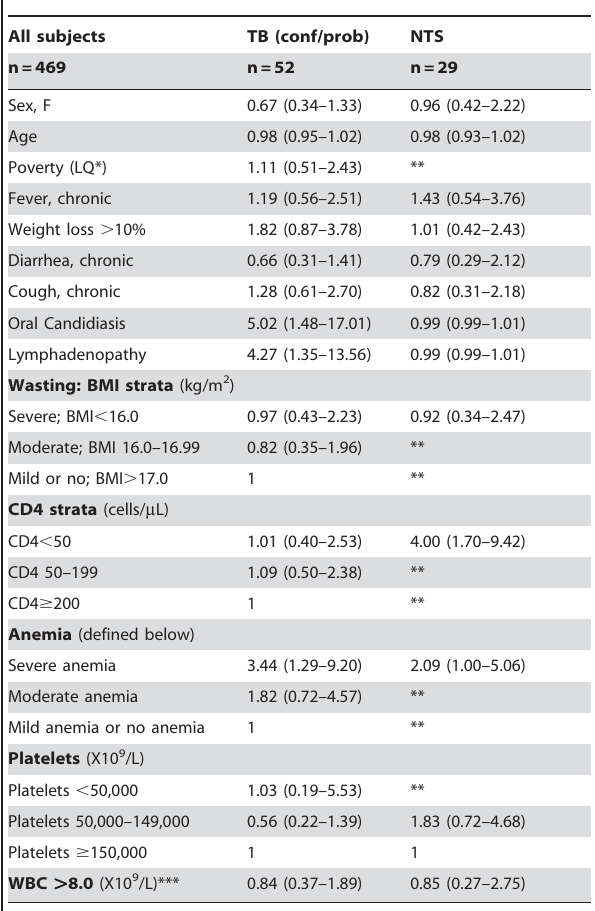
Table 3. Associations of baseline characteristics with laboratory-diagnosed TB or NTS infections: Multivariate